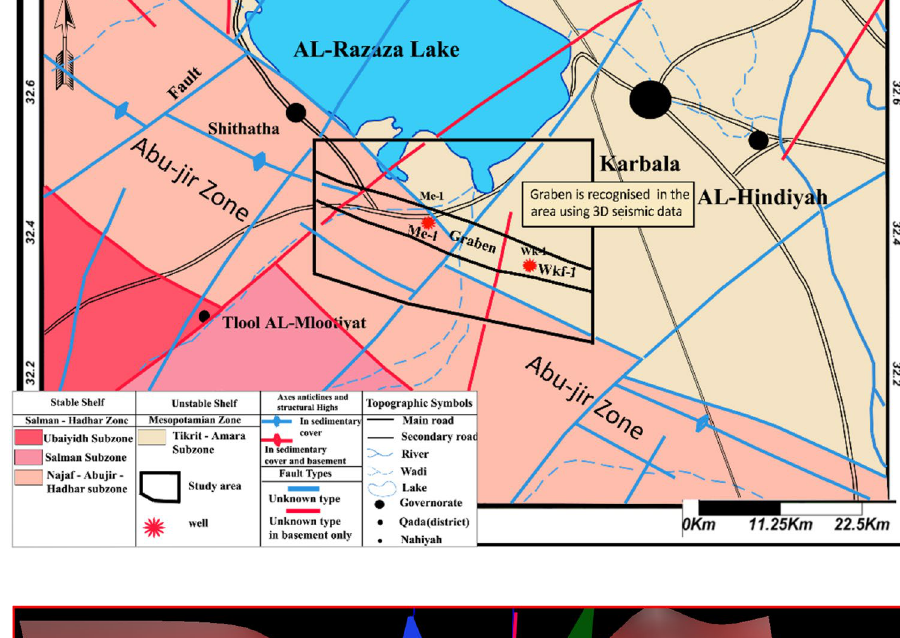
Fig. 7 Time model of the graben effect on the Jurassic succession in the Merjan